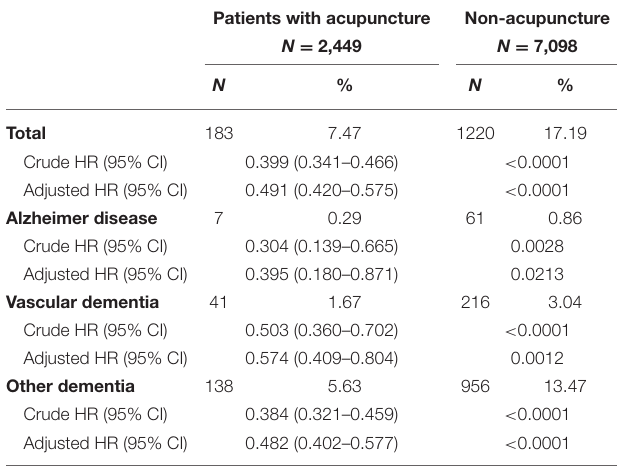
TABLE 3 | Relative risk of developing distinct types of dementia after acupuncture treatment in the stroke patient group. Patients with acupuncture Non-acupuncture